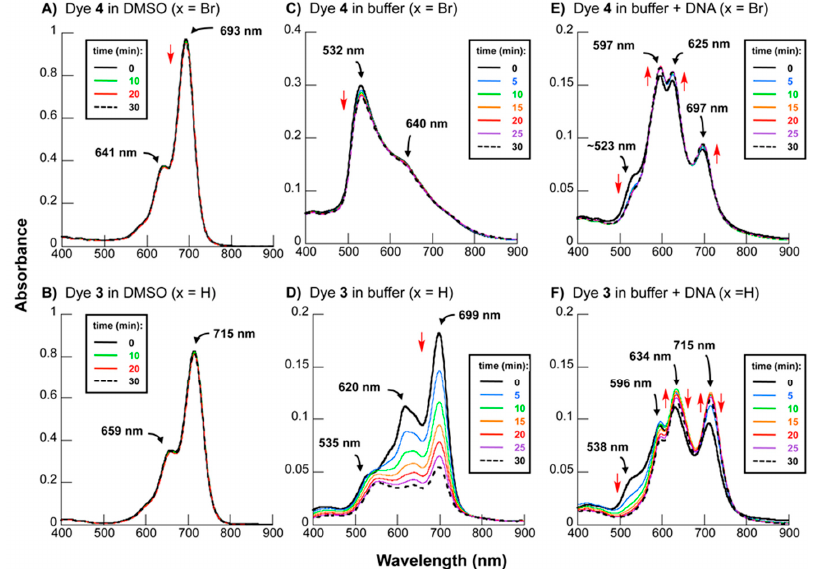
Figure 1. UV–visible spectra recorded over 30 min for 10 µM of dyes 4 and 3 in: ( A ), ( B ) DMSO; ( C ), ( D ) 10 mM sodium phosphate buffer pH 7.0; and ( E ), ( F ) 10 mM sodium phosphate buffer pH 7.0 and 150 µM bp CT DNA (22 °C).